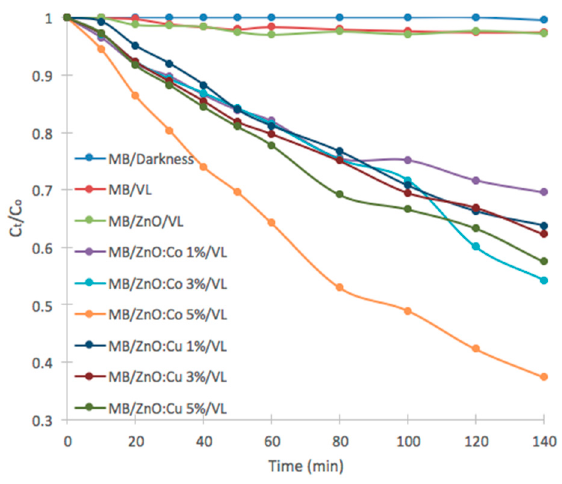
Figure 6. Methylene blue (MB) concentration vs. time of visible irradiation on the synthesized catalysts.